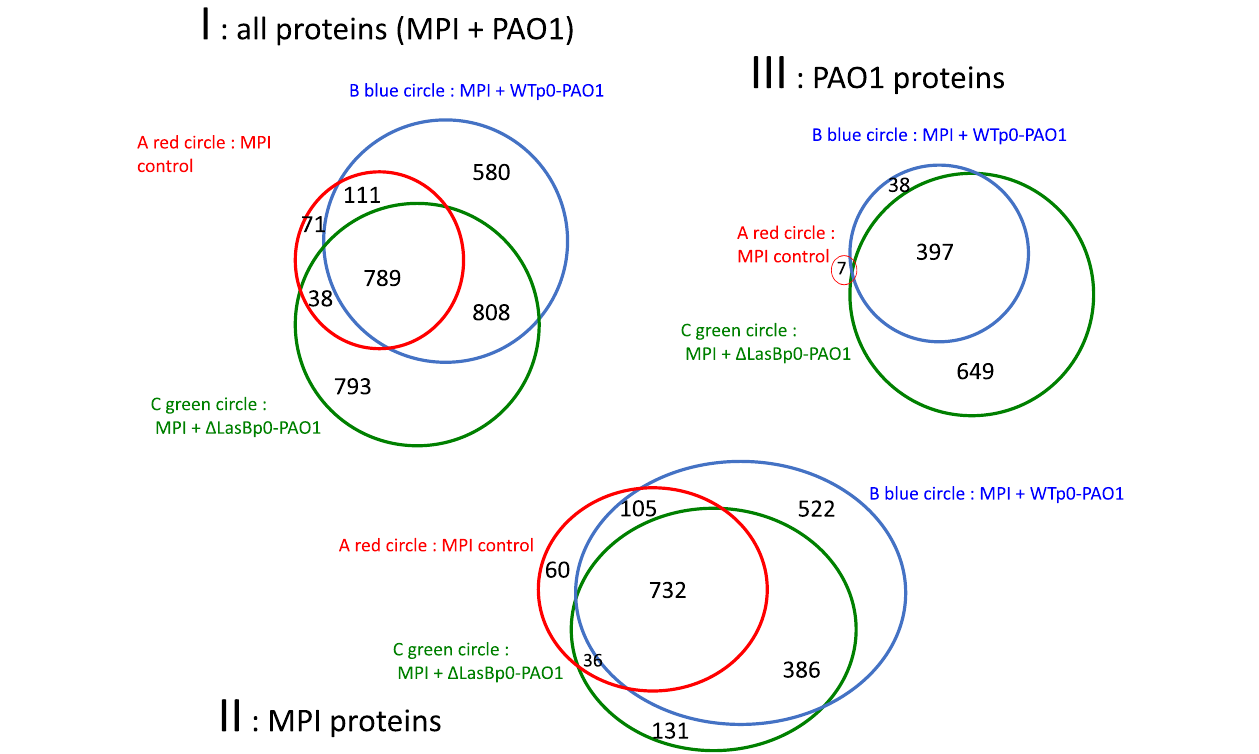
FigUre 6 | Venn Diagrams of total hits recovered in the supernatant of MPI cells, either non-infected (Control) or infected with WTp0- or Δ LasBp0-PAO1. MPI cells were either left un-infected (MPI Control, n = 2) or infected (moi 1) with WTp0- ( n = 3) or Δ LasBp0-PAO1 ( n = 3) in serum-free medium. After 4 h, supernatants were recovered, concentrated and analyzed by mass spectrometry (see Materials and Methods in Supplementary Material). For the identification step, all MS and MS/MS data were processed with the Proteome Discoverer software (Thermo Scientific, version 2.1) coupled to the Mascot search engine (Matrix Science, version 2.5.1). The NCBInr database (2016) with the Mus musculus and the Pseudomonas aeruginosa taxonomies were used for the MS/MS identification step. Peptide identifications were validated using a 1% False Discovery Rate threshold calculated with the Percolator algorithm. Protein abundance variations were measured according to the Hi-3 label-free quantification method and validated if their calculated ANOVA p -values were under 0.05 (see Materials and Methods in Supplementary Material). Venn diagrams generated from “Proteome Discoverer” are shown with numbers referring to the numbers of hits identified. Panel I: all proteins (MPI + PAO1); Panel II: MPI proteins only; Panel III: PAO1 proteins only. Of note, the reported seven bacterial proteins in the “MPI Control treatment” are clearly artifacts (panel III, circle